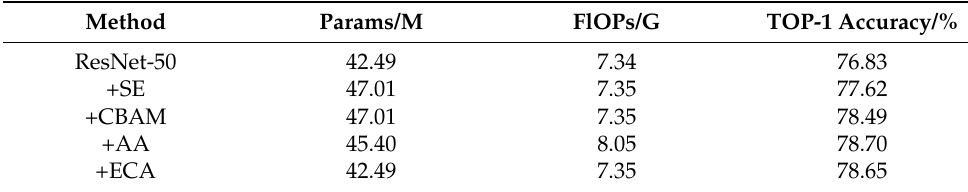
Table 1. Performance indicators of different attention